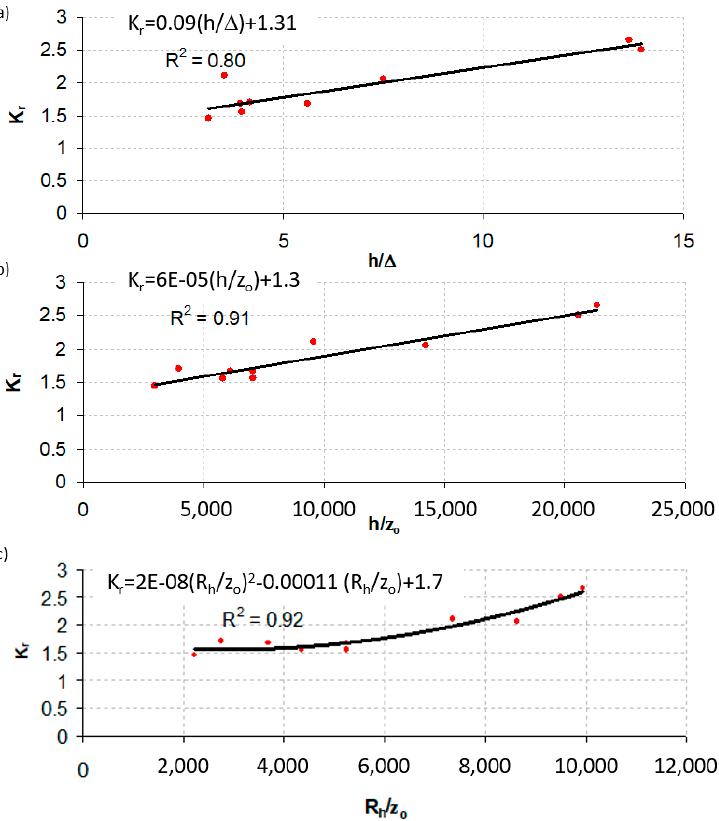
Figure 6. Prediction formula for the calibration coefficient, K r . ( a ) relation with h/ Δ , ( b ) relation with h/z o , ( c ) relation with R h /z o .